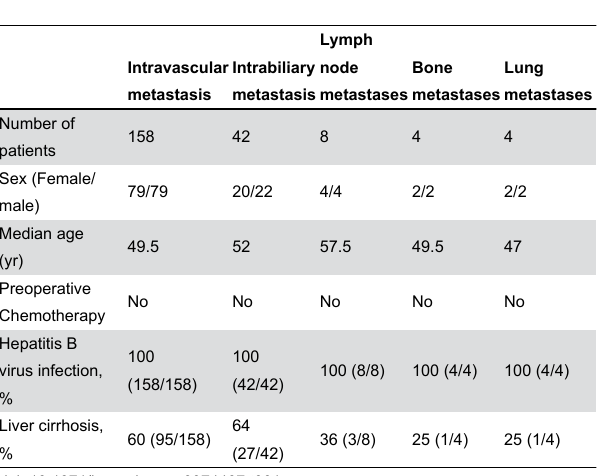
Table 1. Demographic and Clinical Characteristics of 216 HCC Patients with